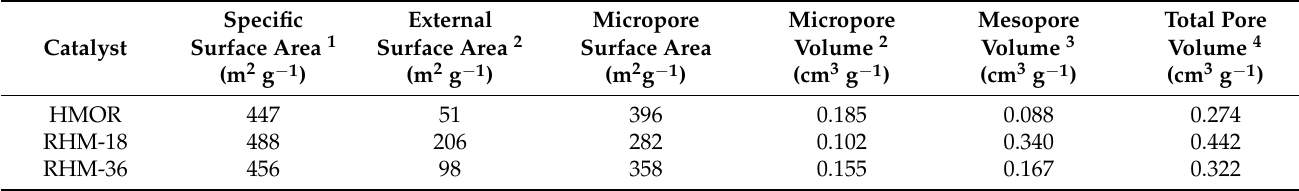
Table 3. Textural properties of HMOR and RHM